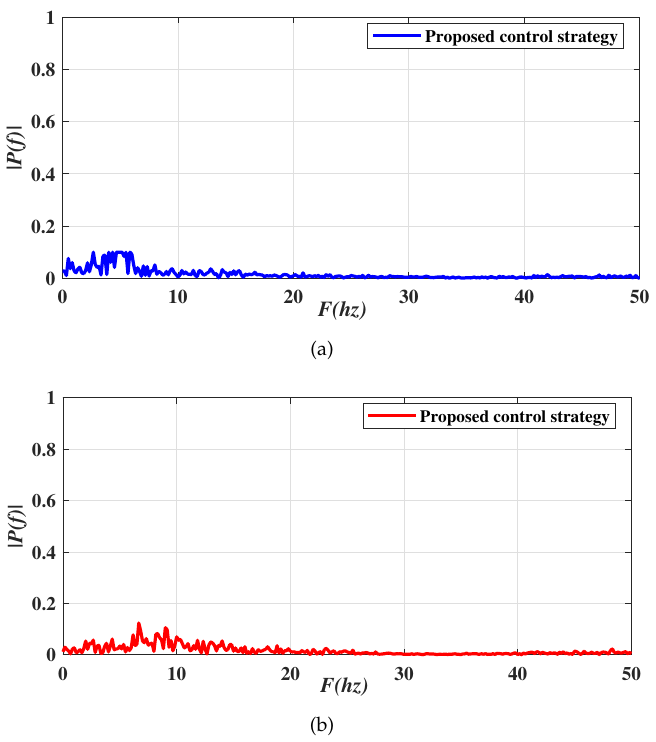
Figure 12. Transformed result of tracking error under theproposed composite control strategy. ( a ) Reference = 20 nm. ( b ) Reference = 50